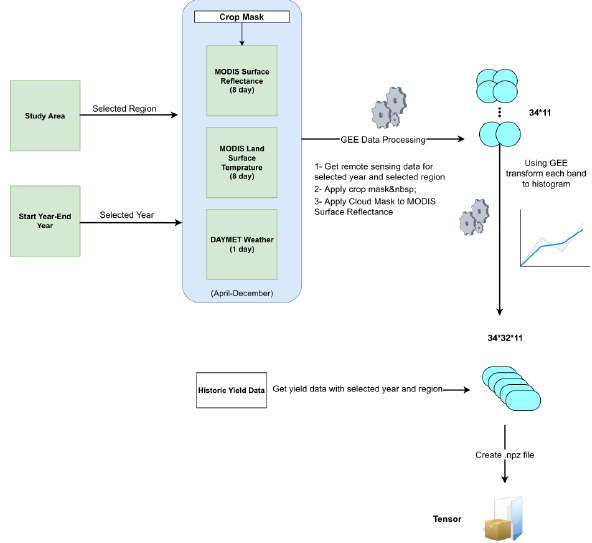
Figure 2. General workflow of tensor